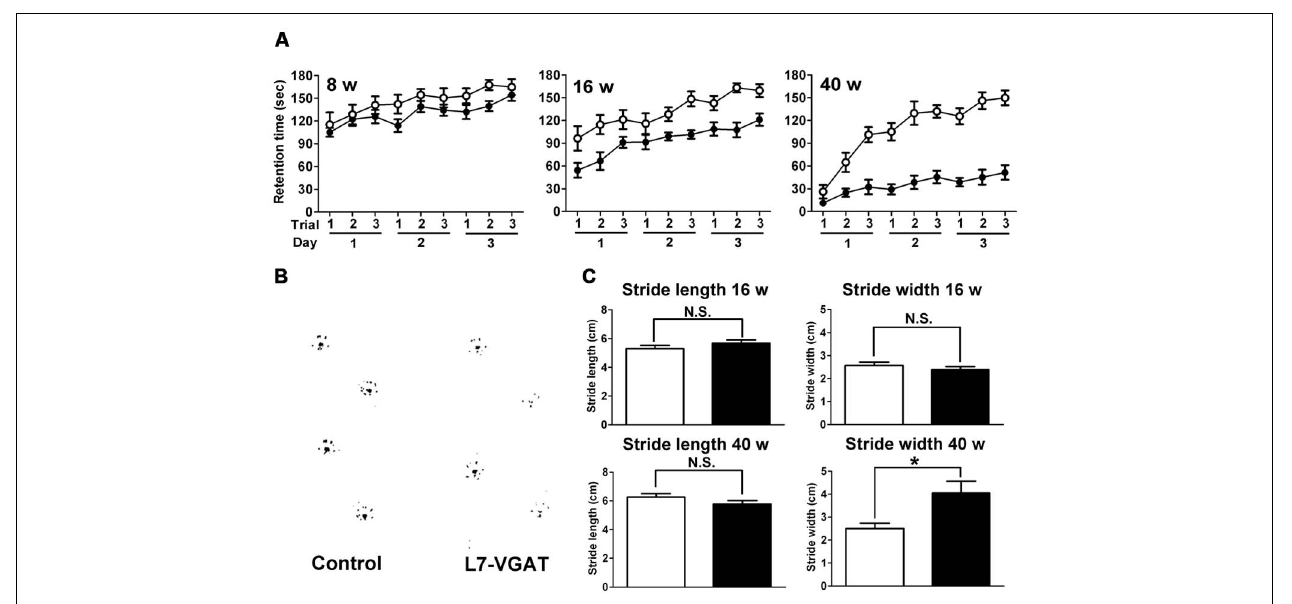
FIGURE 7 |Age-dependent motor dysfunction in L7-VGAT mice. (A) Accelerating rotarod test for control (open circles) and L7-VGAT (filled circles) mice at postnatal weeks 8, 16, and 40. Latencies to fall from the rotating cylinder are plotted against each trial.The male mice were tested with three consecutive trials per day for three consecutive days.The numbers of animals were as follows: control, n = 14, L7-VGAT, n = 7 at P8W; control, n = 11, L7-VGAT, n = 9 at P16W; control, n = 10, L7-VGAT, n = 9 at P40W.